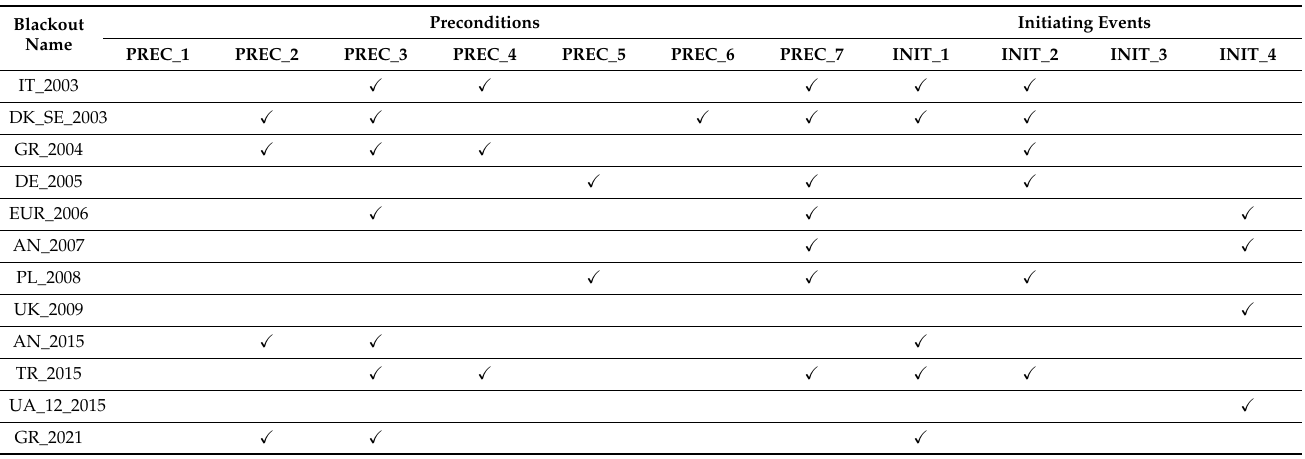
Table 4. Preconditions and the initiating events for all the major blackouts that occurred in Europe in the past 20 years.